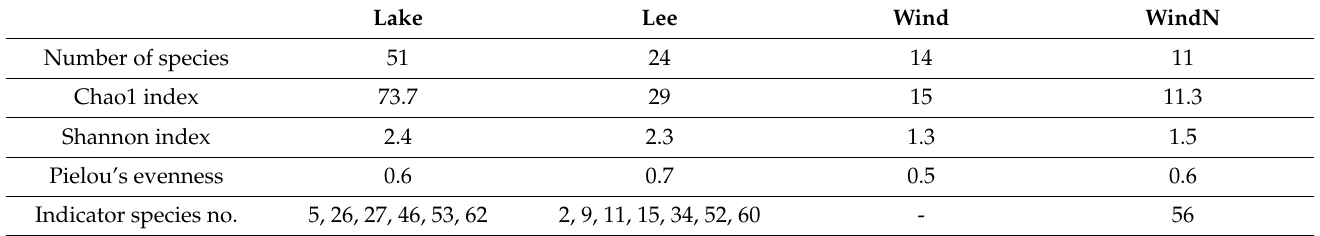
Table 4. Epiphyte diversity and evenness indexes at the four sites. Indicator species are exclusive species of each site. Appendix A lists the number of species.